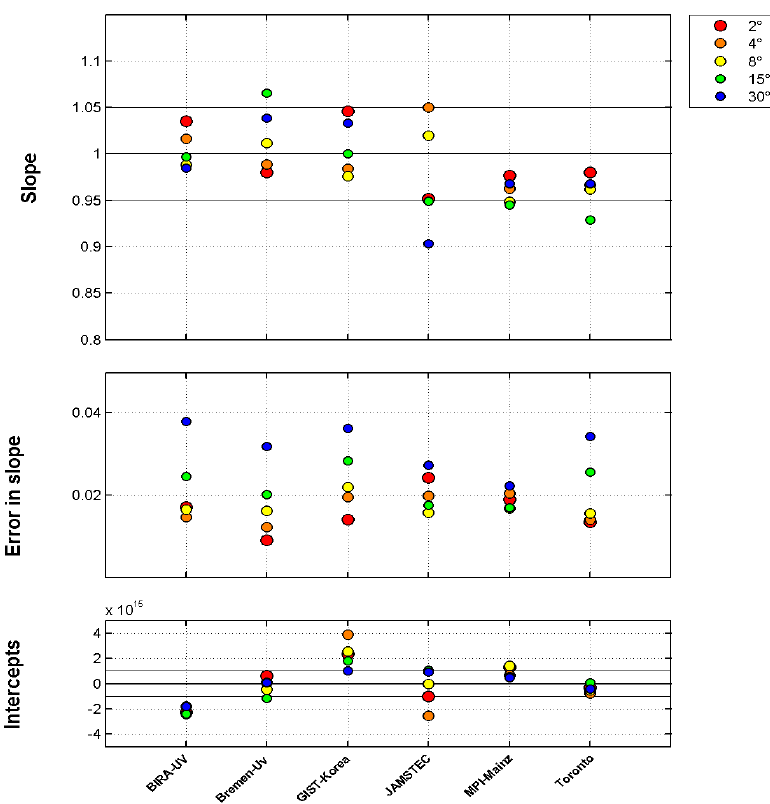
Fig. 13. Straight-line slopes and their errors of NO 2 slant columns against those of the reference data set, for each instrument at UV wavelengths, for some days after the formal campaign so as to include Toronto in their new MAX-DOAS configuration. Colours refer to elevation angles shown top right. Some UV instruments are missing because they ceased operations after 30 June.